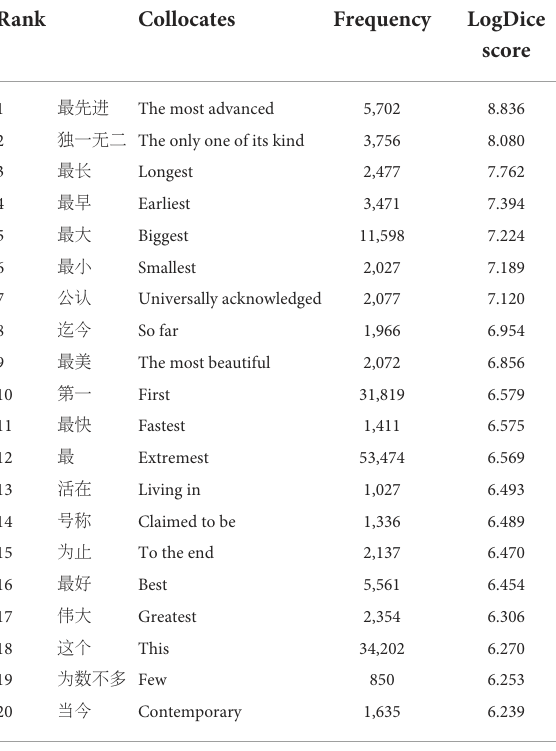
TABLE 6 The collocates of 世 界 上 shi4jie4shang4 (in the world) within a four-word span.